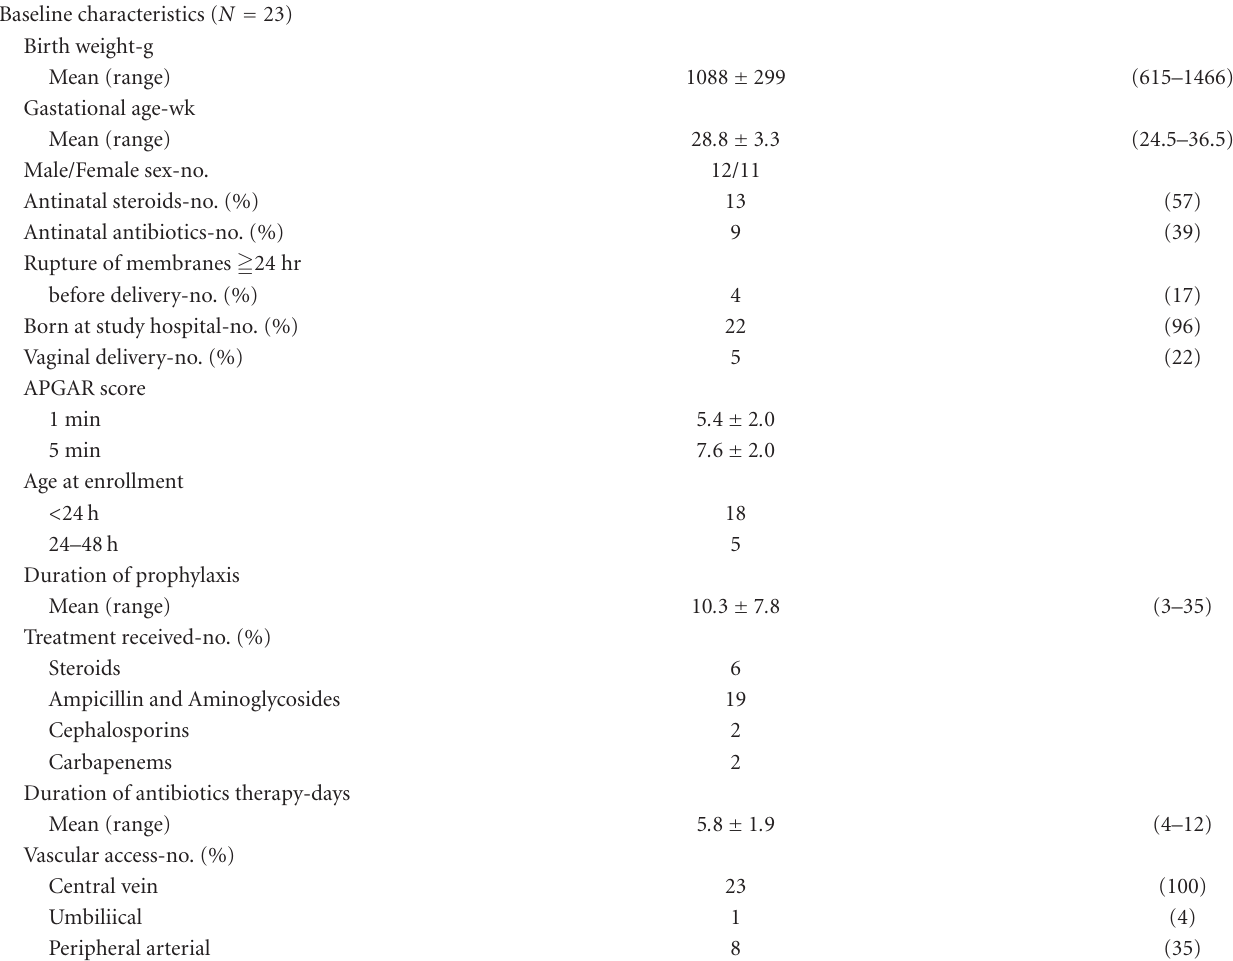
Table 1: Characteristics of the patients’ risk factors for invasive fungal infection.